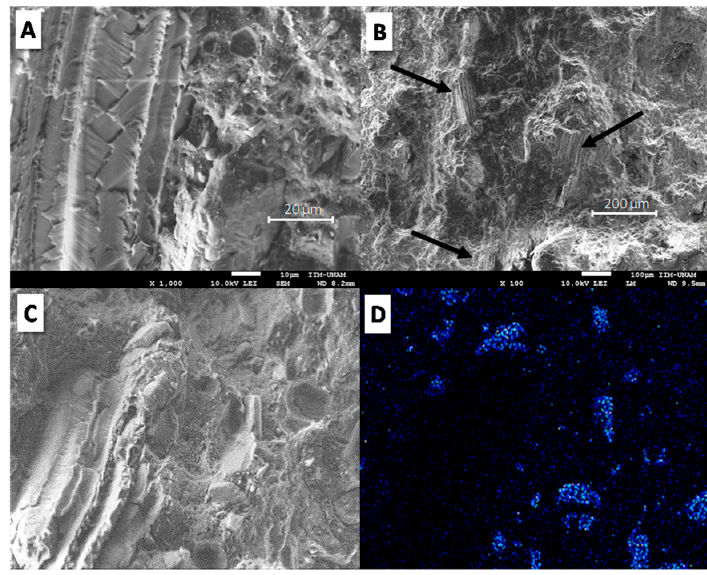
Figure 5. SEM micrographs of TPS/20CF/10APP at two different magnifications ( A , B ). Elemental analysis of TPS/20CF/10APP: ( C ) scanned area and ( D ) phosphorus mapping.